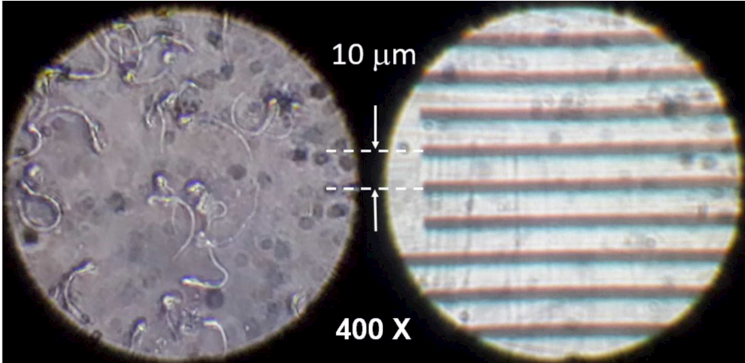
Figure 9. Effective magnification of the developed inverted